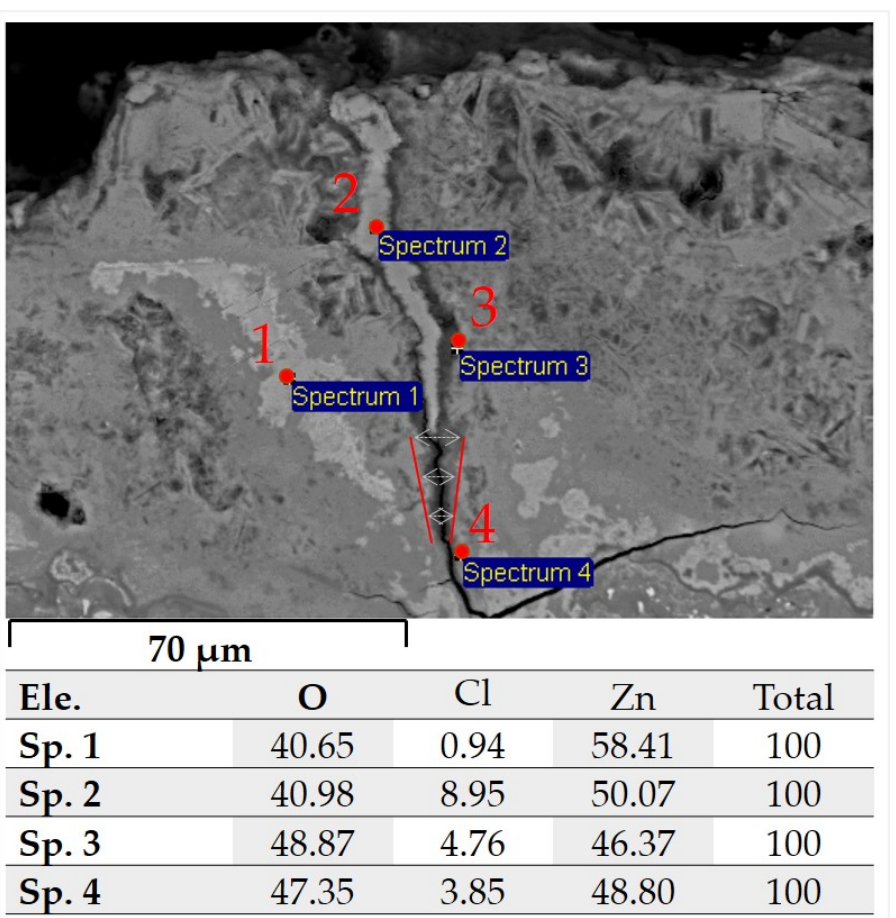
Figure 18. Crack initiation and growth in a corroded ZnAl coating.